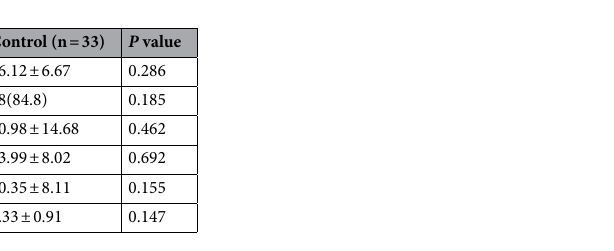
Table 2. Comparison of lymphocyte subsets between TAK patients and control group.